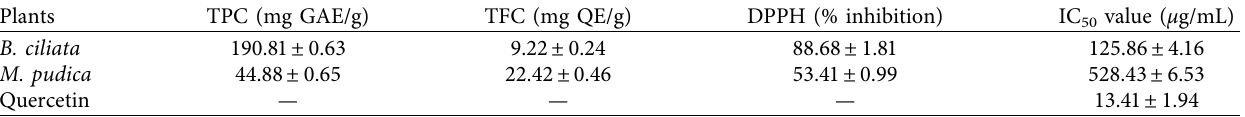
Table 2: Total phenolic content, flavonoid content, and antioxidant activity of selected plants. Plants